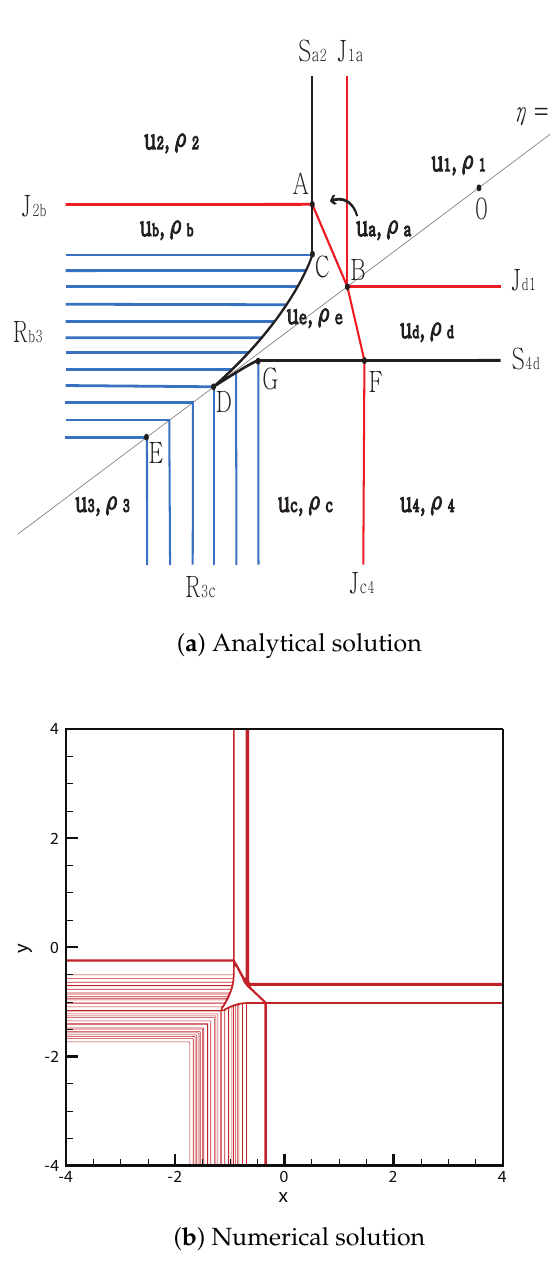
Figure 14. Case 12. JS + JR + RJ +